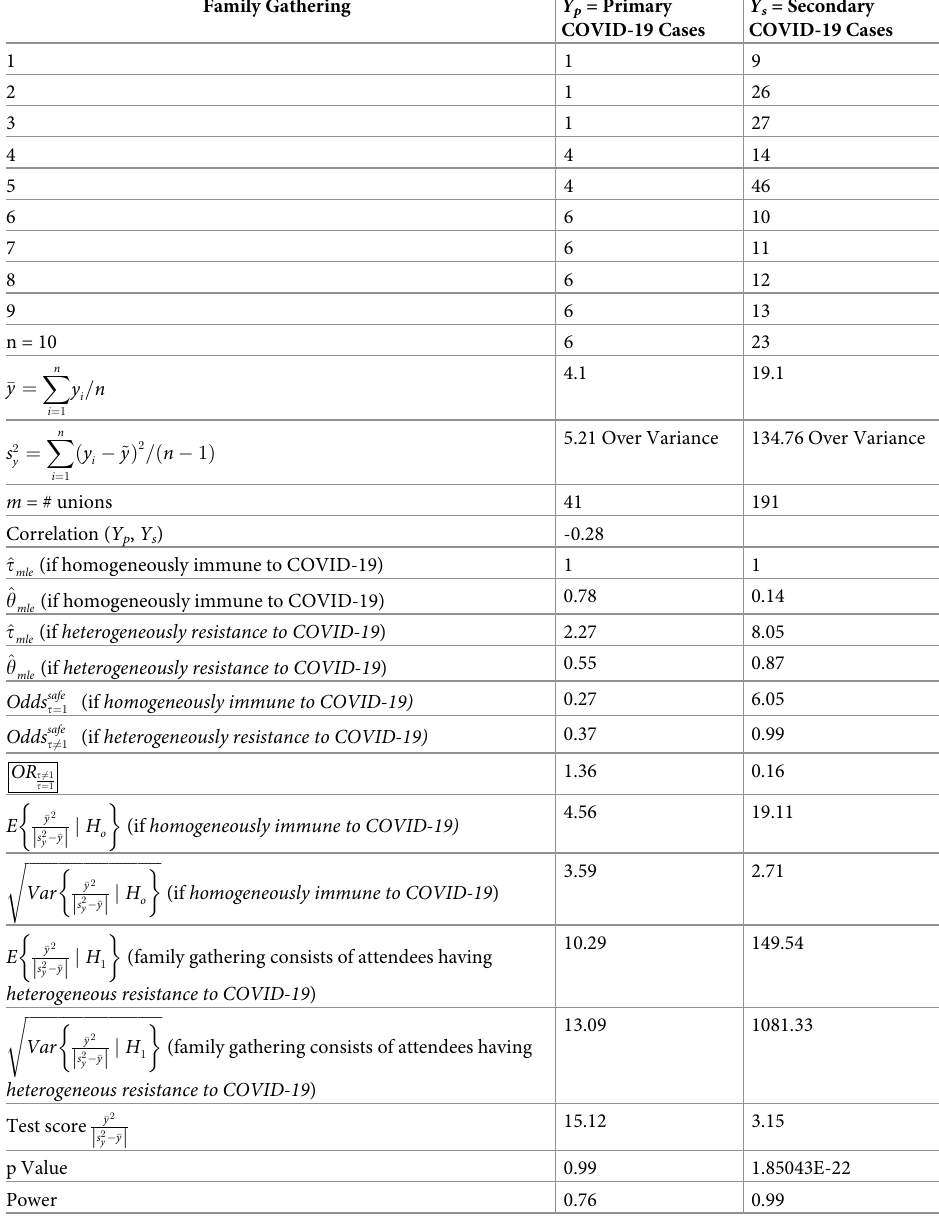
Table 1. The family gathering in which the primary cases were in single digit (with over variance).